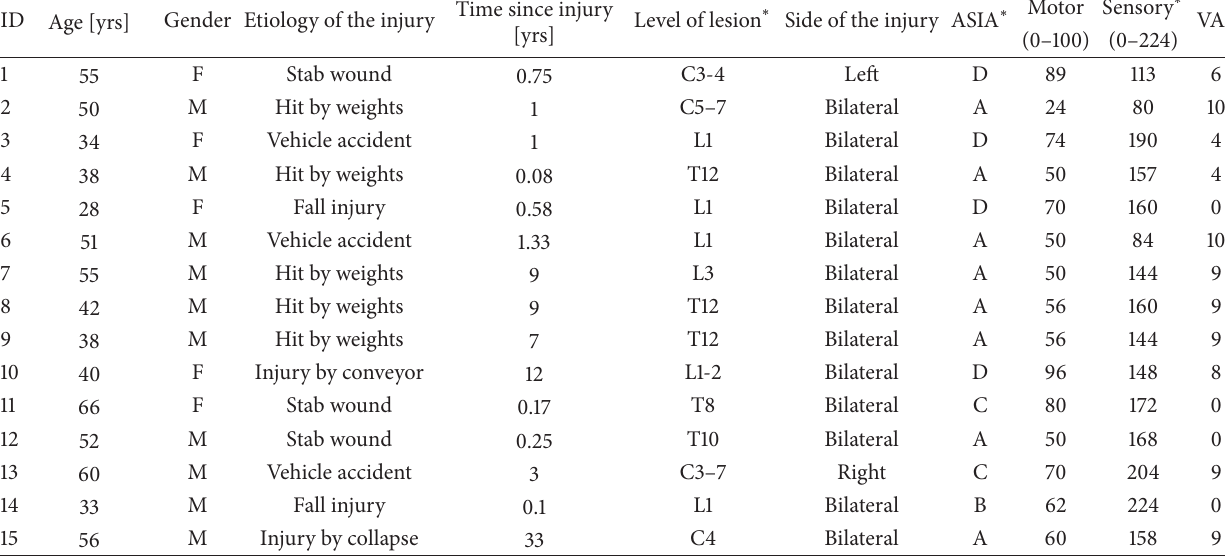
Table 1: Clinical data for the spinal cord injured